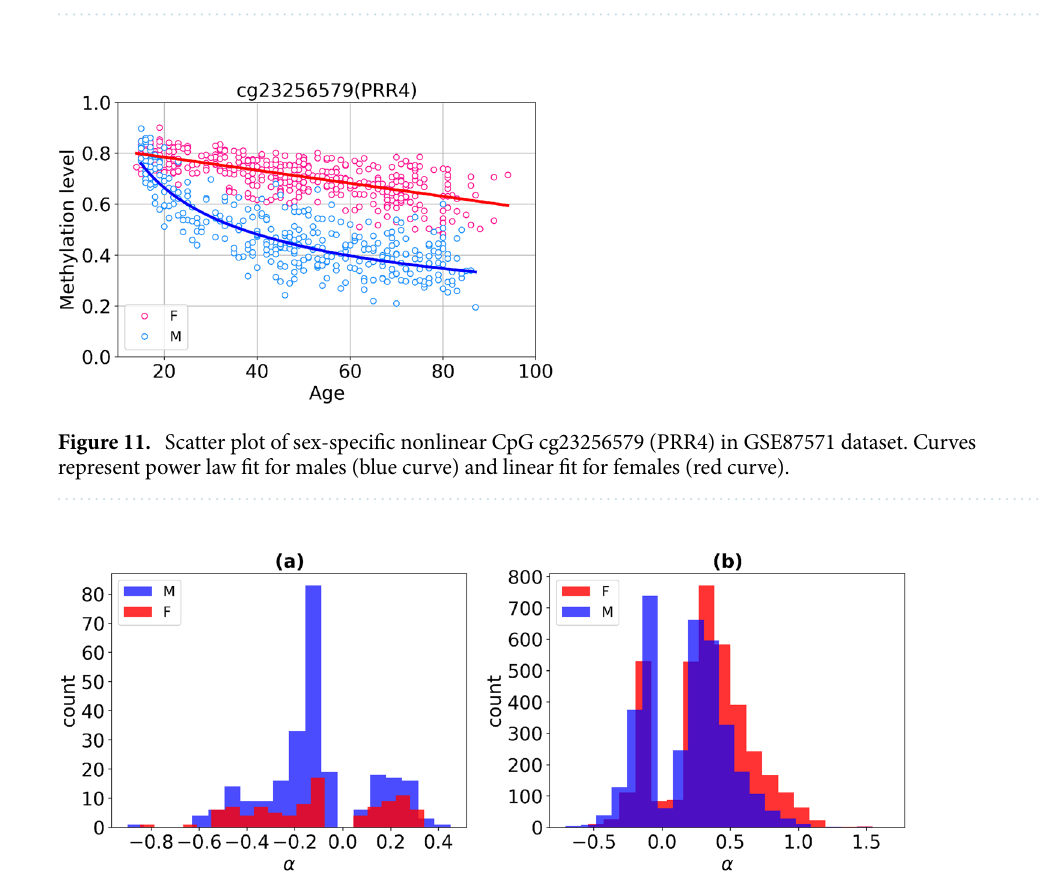
Figure 10. Scatter plots of power law CpGs identified in GSE87571 dataset. Curves represent power law fits β ∼ age α or 1 − β ∼ age α for males (blue curves) and females (red curves). ( a , c ) on the left panel show probes with a methylation level far from the limits, the right panel gives examples of nonlinearity due to saturation to 0 ( b ) and 1 ( d ).